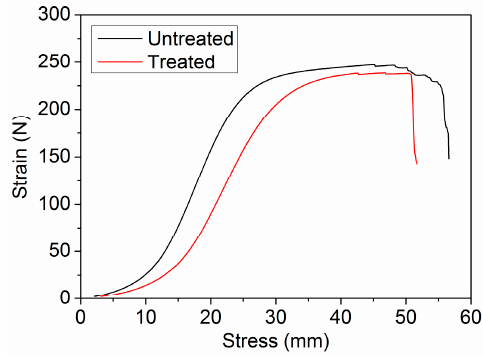
Figure 15. Stress-strain curves of the untreated and treated wool fabrics.